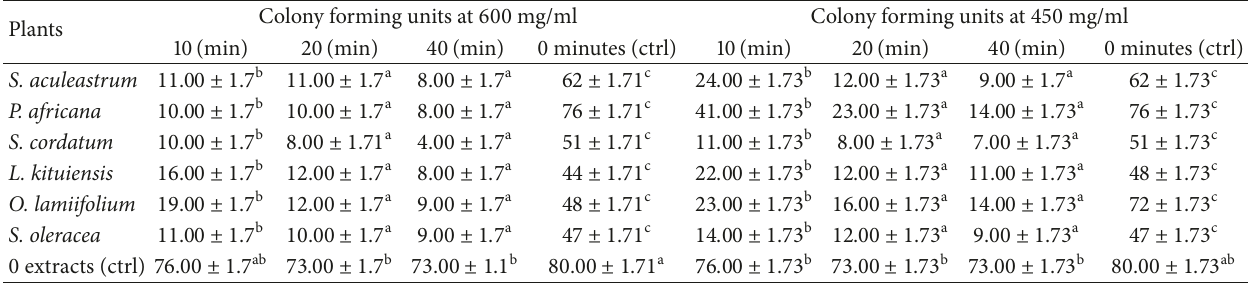
Table 5: Effect of organic plant extracts and photosensitization on Aspergillus flavus (UONV017). Colony forming units at 600 mg/ml Colony forming units at 450 Plants